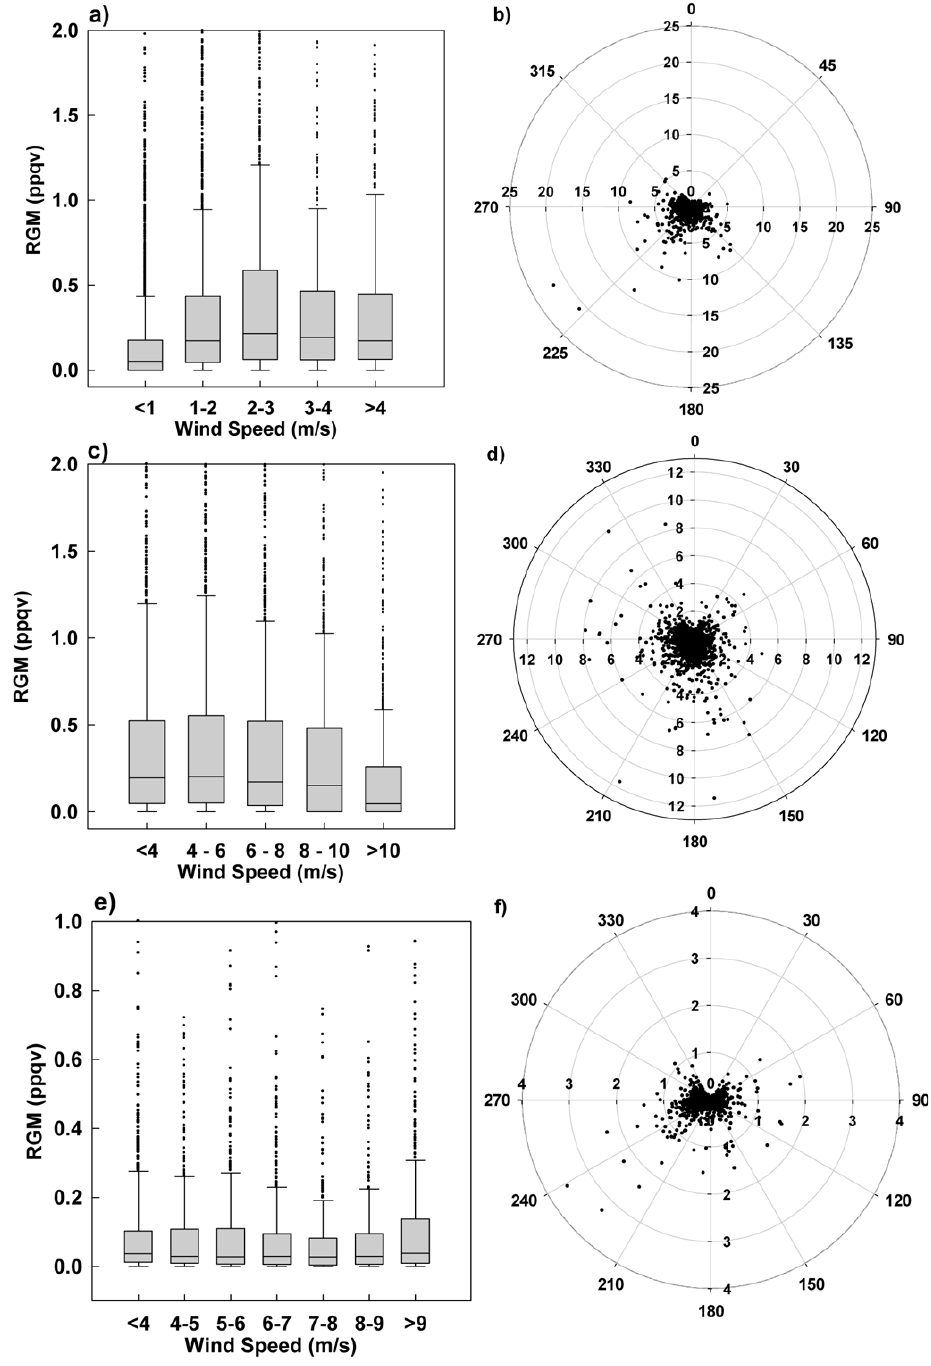
Fig. 4. RGM mixing ratios versus wind speed and direction at TF (coastal) (a, b) , AI (marine) (c, d) , and PM (inland) (e, f) .